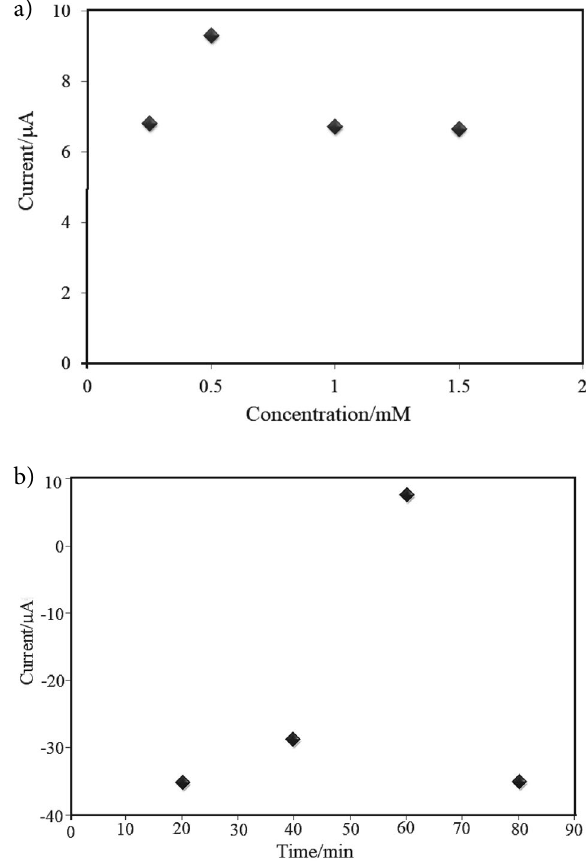
Figure 4. Variation of anodic peak current towards oxidation of 1 mM glucose in 0.1 M NaOH with different (a) KAuCl 4 concentra- tions (b) Deposition time.